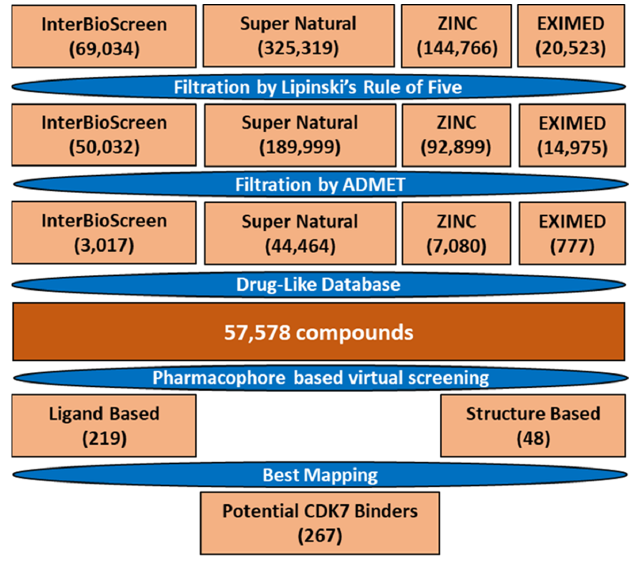
Figure 5. Generation and virtual screening of the natural drug-like database. Four natural com- pound libraries—InterBioScreen, SuperNatural2, ZINC, and ExiMed were used in the present